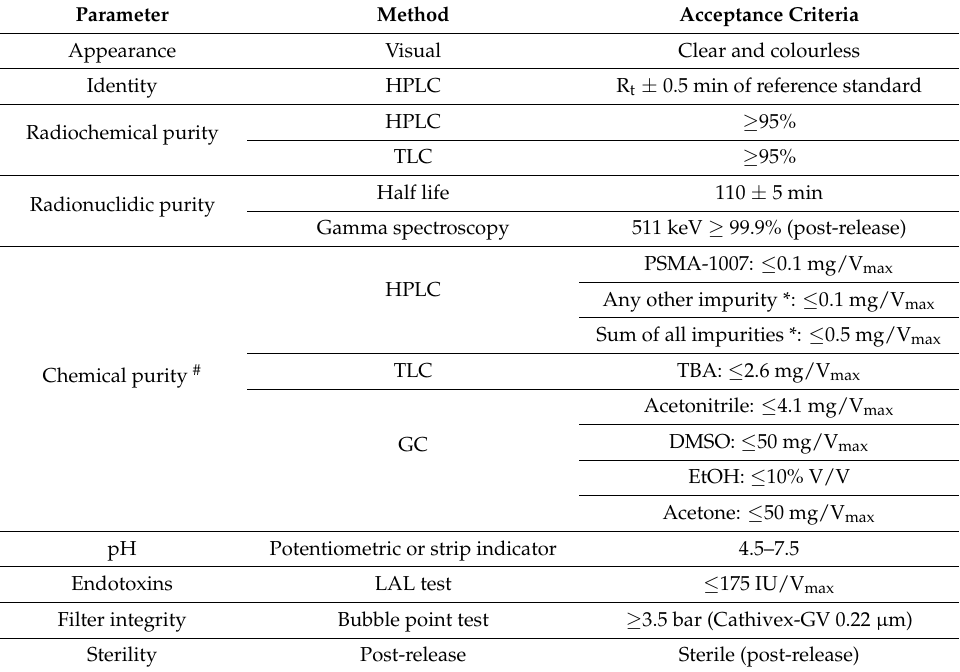
Table 1. Recommended tests for the quality control (QC) of [ 18 F]PSMA-1007 injection solution. LAL: limulus amebocyte lysate.